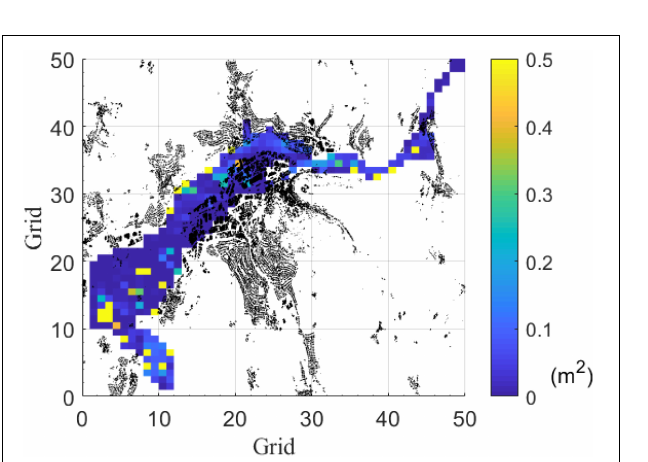
FIGURE 10 | Average MSE difference between the ANN and the hydrodynamic model of the historical event in February 2005. Black elements are houses. Comparison of average MSE to observed inundation depth (historical event in February 2005). Each grid is an ANN.